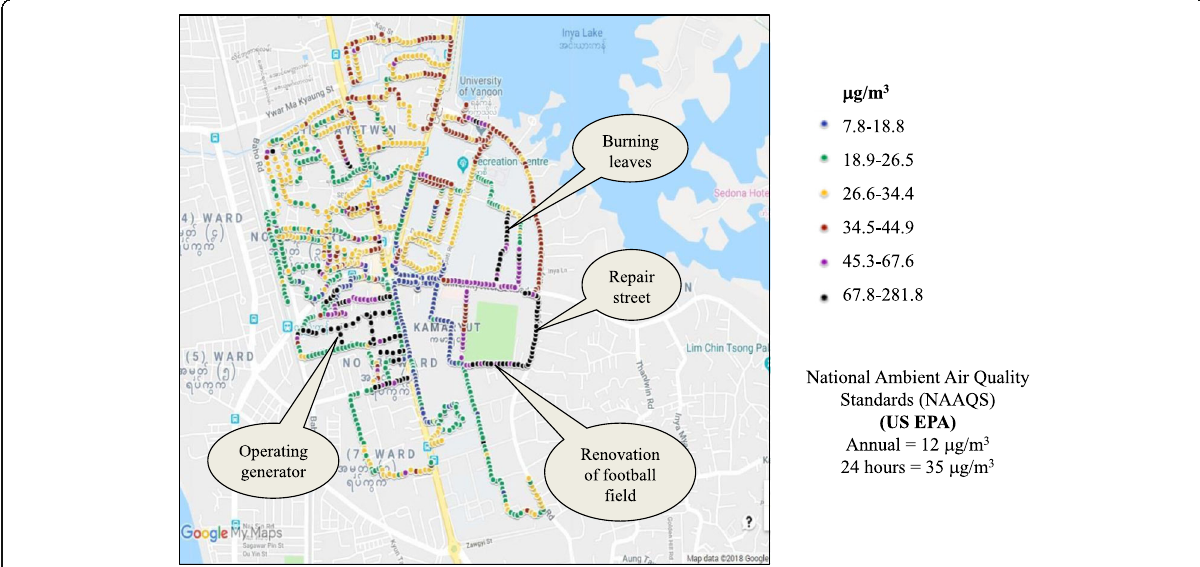
Fig. 5 Mapping of PM 2.5 in Kamayut Township, Yangon, Myanmar. The starting point was near the Kamayut-Hledan junction and planned eight tracks. Eight investigators arrived at the starting point at 15:00 h and recorded the PM 2.5 concentrations and screen color. Afterwards, they walked along the eight tracks simultaneously for 30 min and collected PM 2.5 concentrations. (Plotted on Google